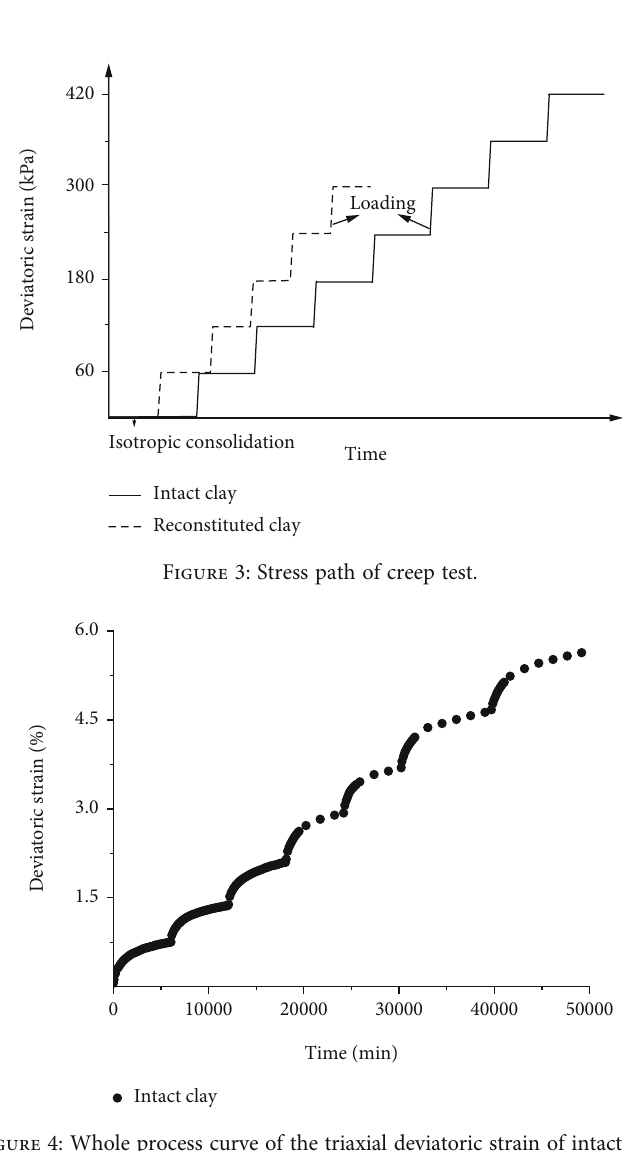
Figure 4: Whole process curve of the triaxial deviatoric strain of intact